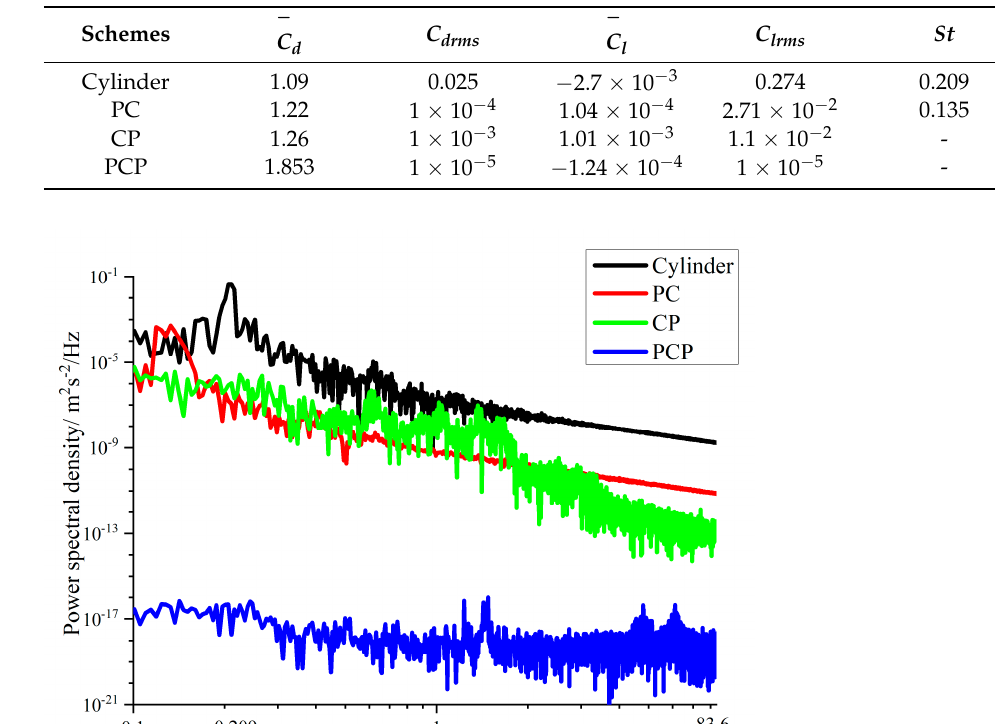
Figure 12. Time histories of lift and drag coefficients: ( a ) lift coefficient; ( b ) drag coefficient. Table 4. Comparison of time-averaged and RMS results of lift and drag coefficients.